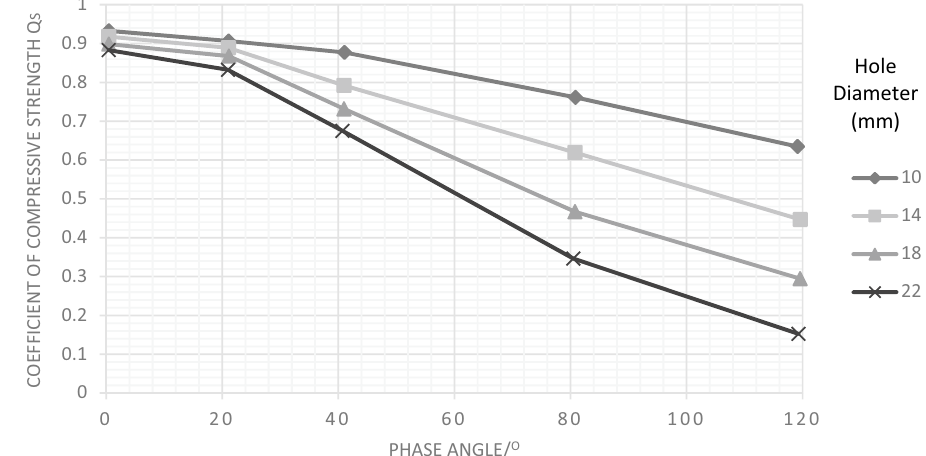
Fig. 7 Influence of hole diameter on collapse resistance strength at different